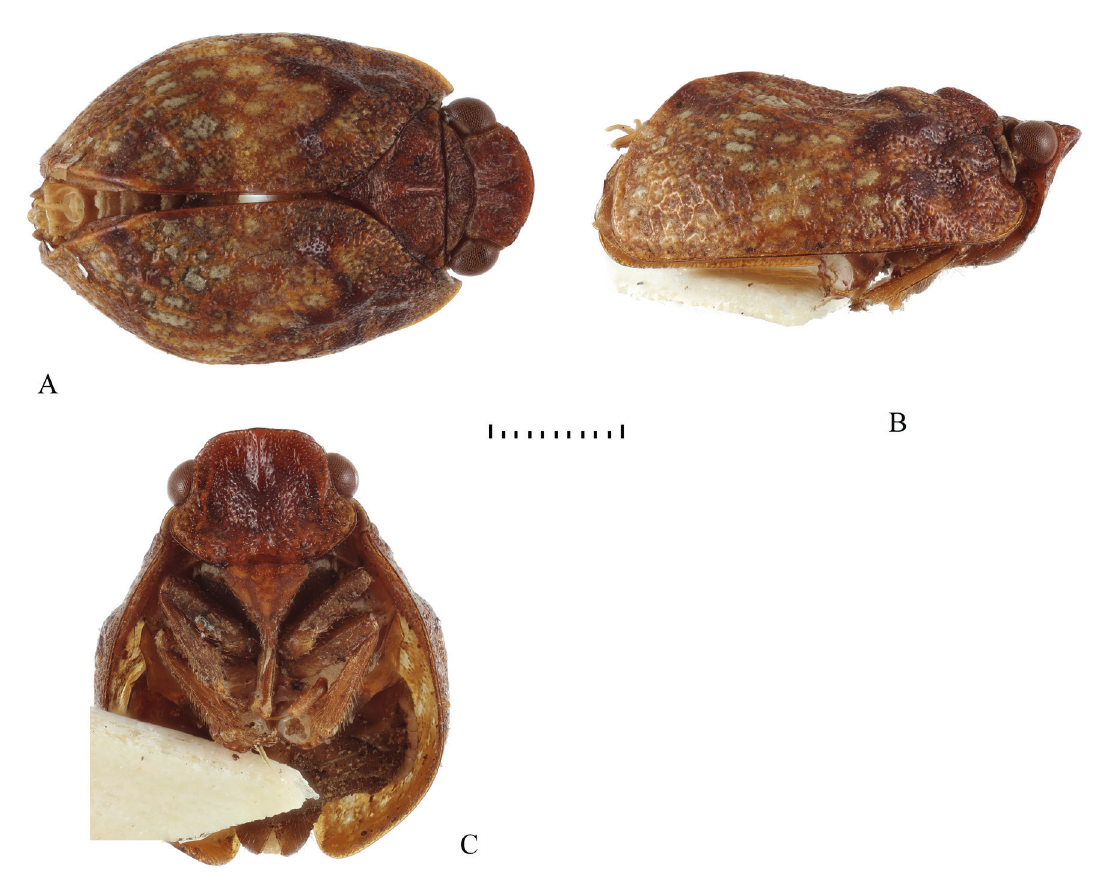
Fig. 1. Superciliaris anichkini sp. nov., ♂, holotype (ZIN), external view. A . Dorsal view. B . Lateral view. C . Frontal view. Scale bar = 1